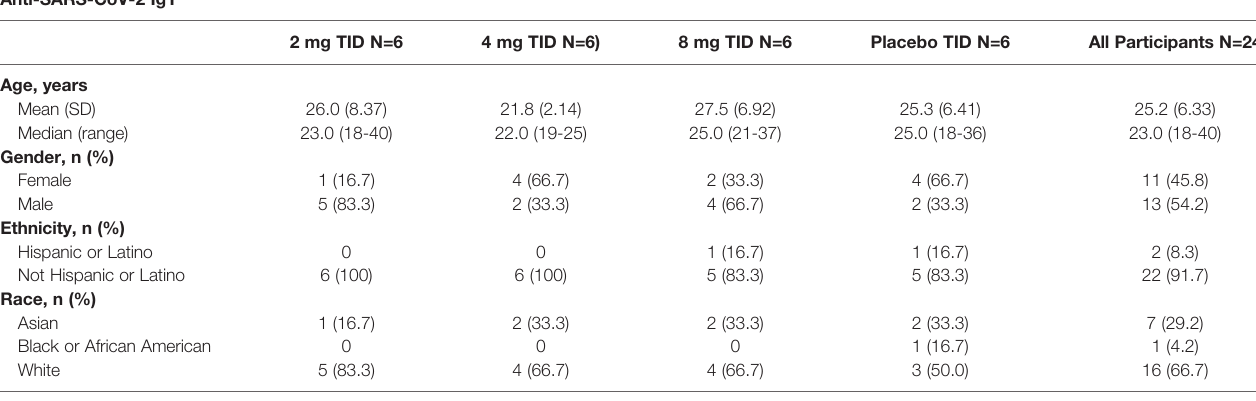
TABLE 2 | Demographics of participants in the multiple-dose group (Part 2).